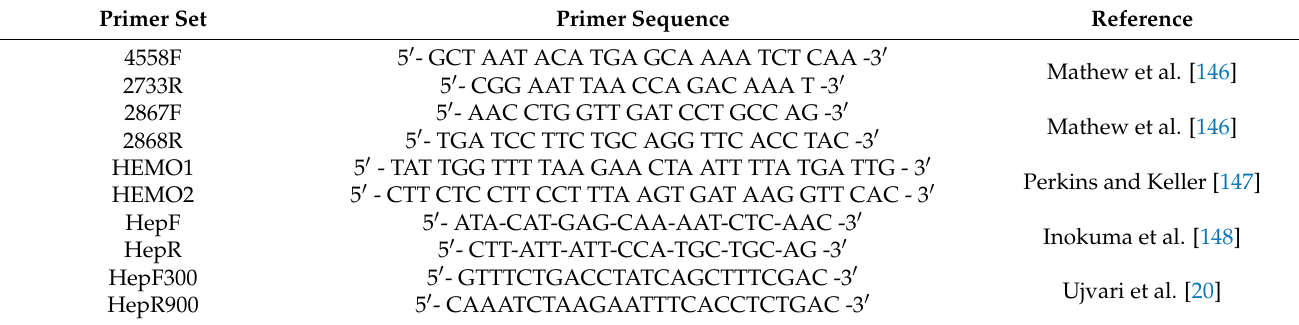
Table 10. Primer sets used in the phylogenetic analysis of haemogregarines by 18S rRNA gene. Primer Set Primer Sequence